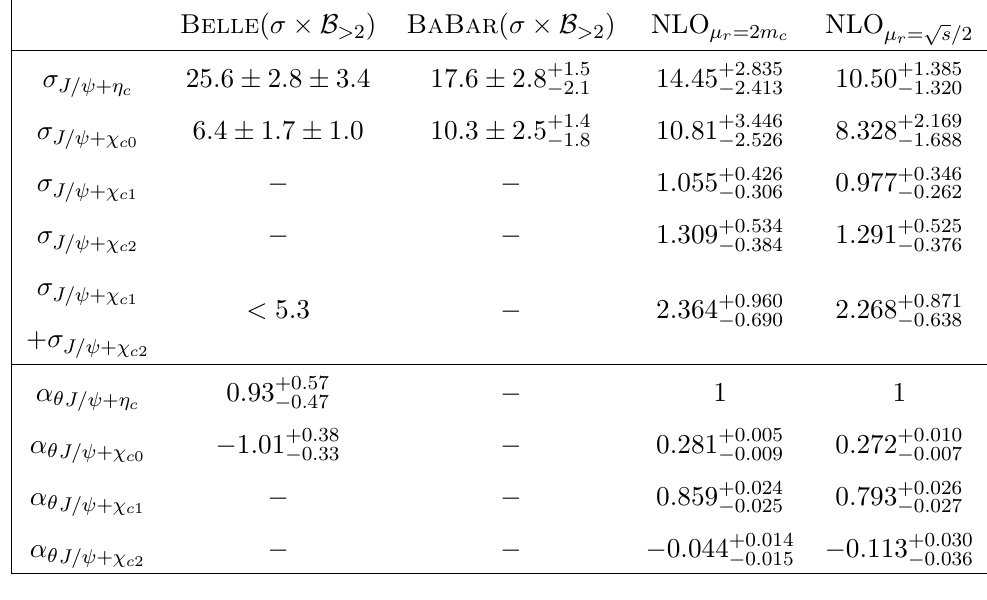
Table 7 . Comparisons of our predictions of total cross sections (in unit: fb) and α θ with Belle √ and BaBar measurements at s = 10 . 6 GeV. The uncertainties in the predictions are caused by varying m c in [1 . 4 , 1 . 6] GeV around the central value of 1 . 5 GeV. B > 2 denotes the branching ratio of η c ( χ cJ ) into two or more charged